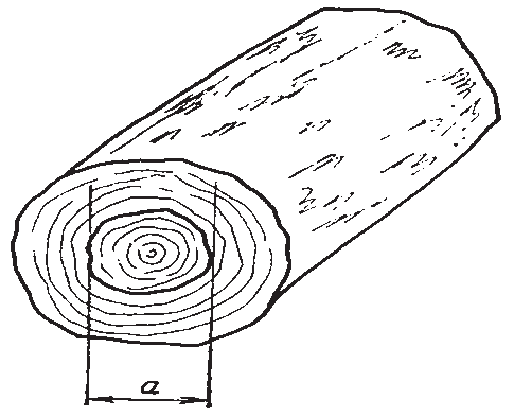
Figure 1 Measurement of false heartwood (STN EN 1310)